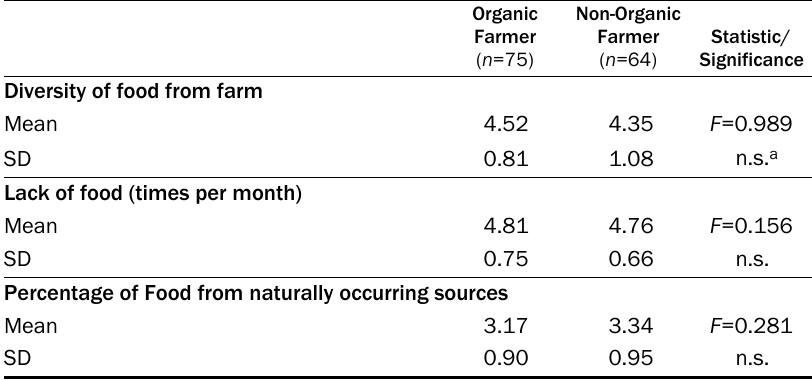
Table 9. Differences in Food Security Between Organic and Non-Organic